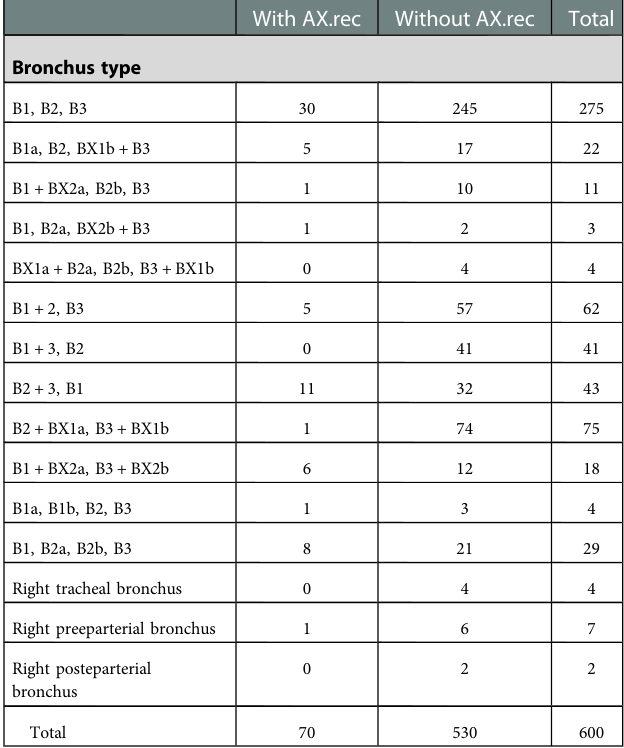
branching types ( Table 1 ): B1a, B1b, B2, B3 (0.7%), which